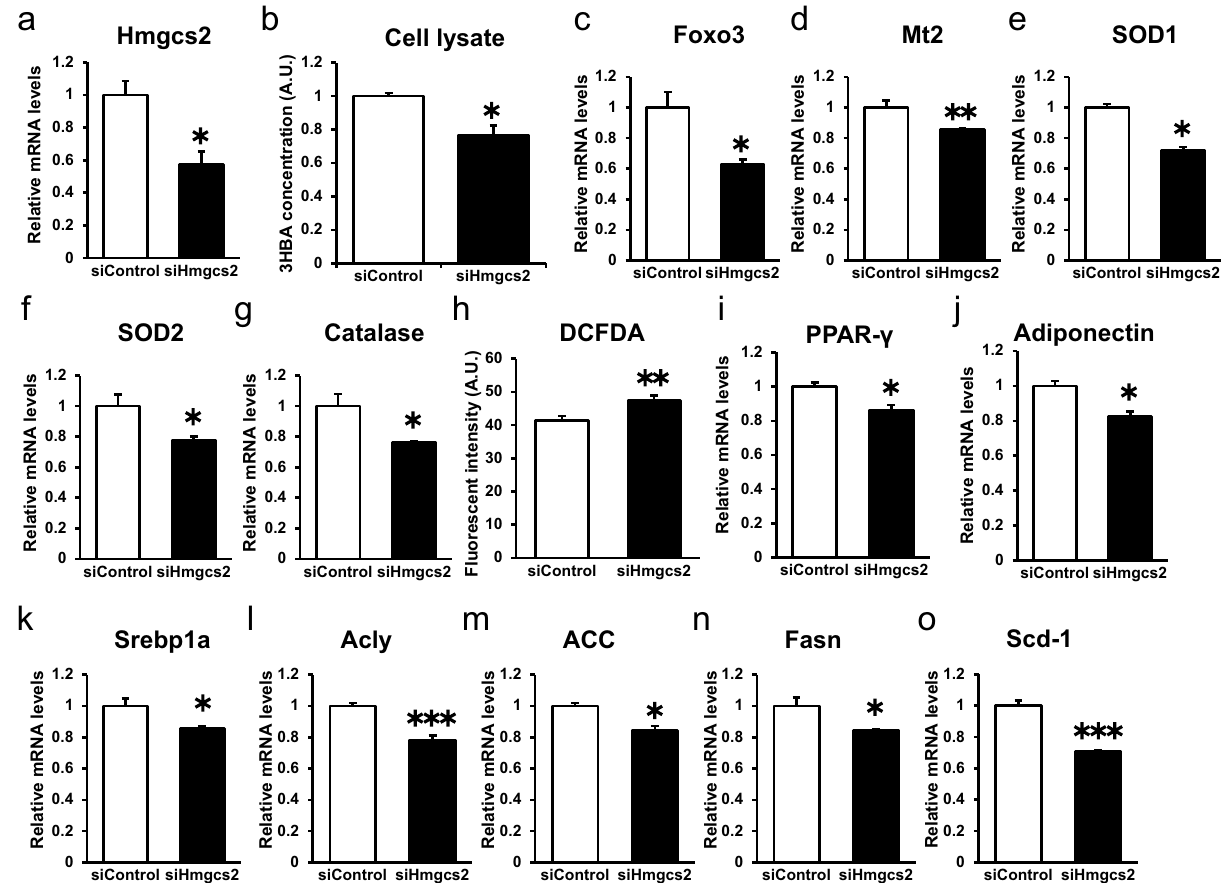
Figure 7. Hmgcs2 regulates antioxidative stress factors and ROS, PPARγ, and lipogenic factors in an autocrine manner by endogenous 3HBA production in adipocytes. On day 3 after 3T3-L1 adipocytes were differentiated, siRNA was introduced by reverse transfection for 48 h, and forward transfection was performed for 48 h. On day 7 after differentiation, the 3T3-L1 adipocytes were maintained in serum-free DMEM composed of 25 mM glucose and 1 nM insulin for 24 h, followed by harvest on day 8 after differentiation. ( a ) qRT–PCR of Hmgcs2. ( b ) 3HBA concentration in cell lysate. n = 3. ( c – g ) qRT–PCR of antioxidative stress factors. n = 3. ( h ) Cellular ROS detected by 2 ′ ,7 ′ -dichlorofluorescein diacetate (DCFDA) assay. n = 3. ( i , j ) qRT–PCR of PPARγ and Adiponectin. n = 3. ( k – o ) qRT–PCR of lipogenic factors. n = 3. Data are mean ± SEM. * p < 0.05, ** p < 0.01, *** p < 0.001. A.U., Arbitrary